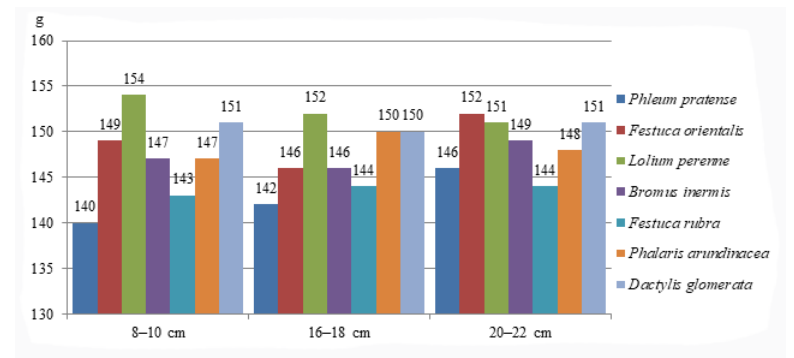
Figure 2 Average provision of feeding units with digestible protein from perennial pasture grasses, depending on the depth of main soil tillage, from 2011 to 2013.